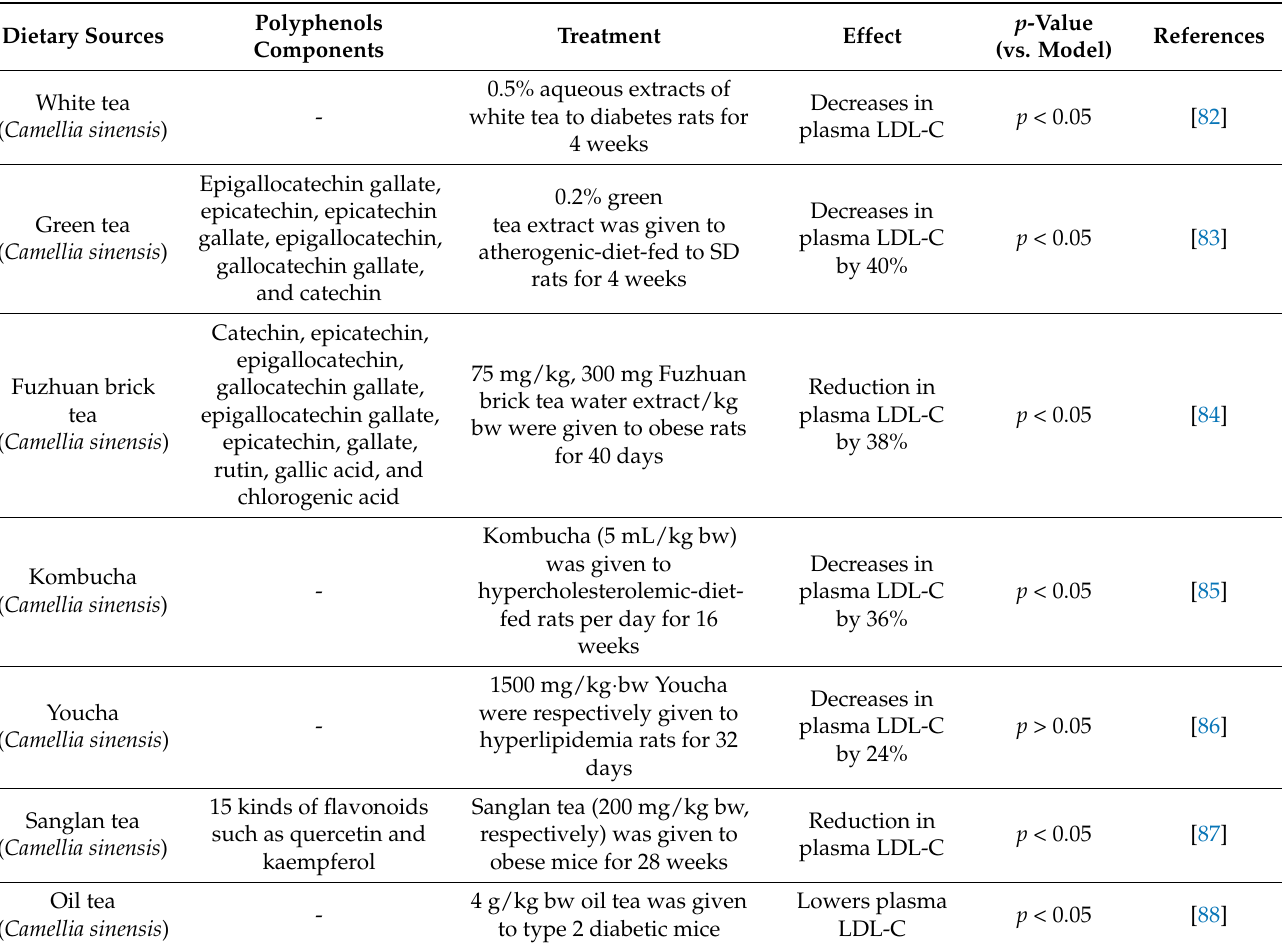
Table 2. Dietary sources, polyphenols, and cholesterol-lowering activities in animal